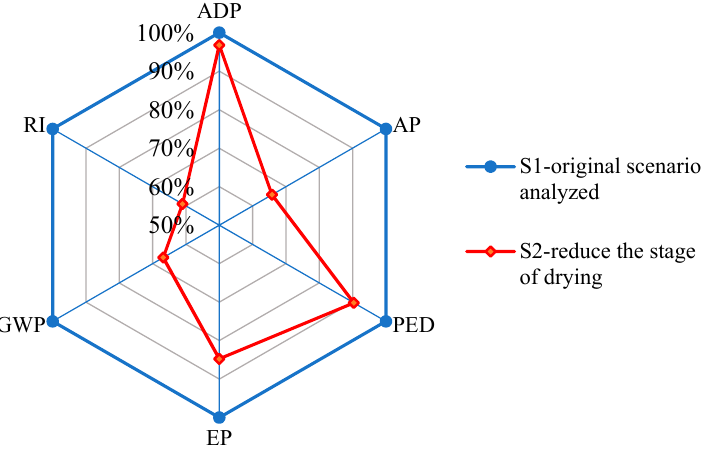
Figure 5. Analysis to reduce drying stage.